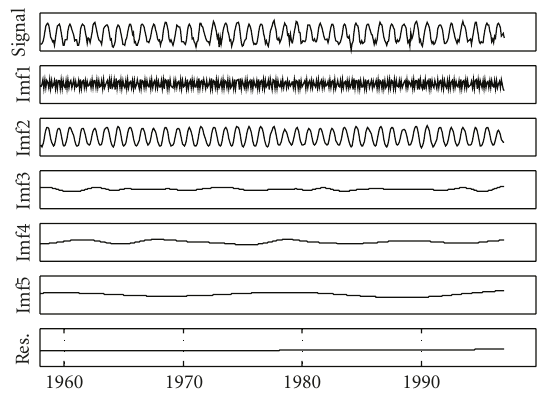
Figure 7: EMD results of the method in this